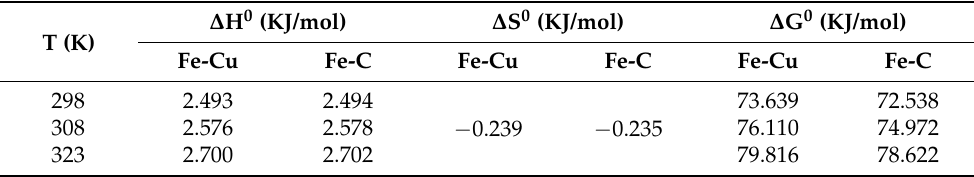
Table 4. Thermodynamic parameters for the removal of CIP by materials Fe-Cu and Fe-C. ∆ H 0 T (K)